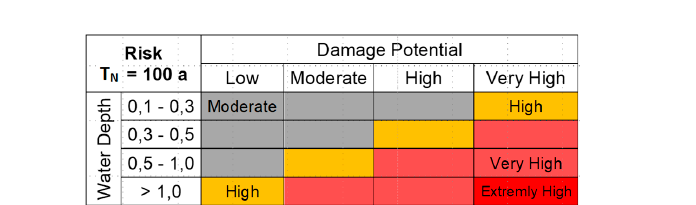
Table 3. Exemplary damage potential classification of different land uses. Object/Land use Damage Potential/Class Parks, Garden plots, Green areas, etc. Low/1 Residentials without basements, Small businesses, etc. Moderate/2 Residentials with basements, Industries, etc.